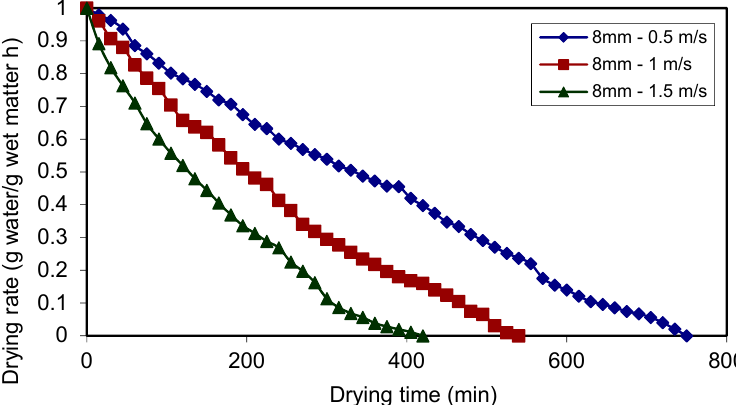
Figure 6. Drying rate as a function of drying time for drying air velocity of 0.5, 1 and 1.5 m/s and slice thicknesses of 8 mm for kiwi fruits.